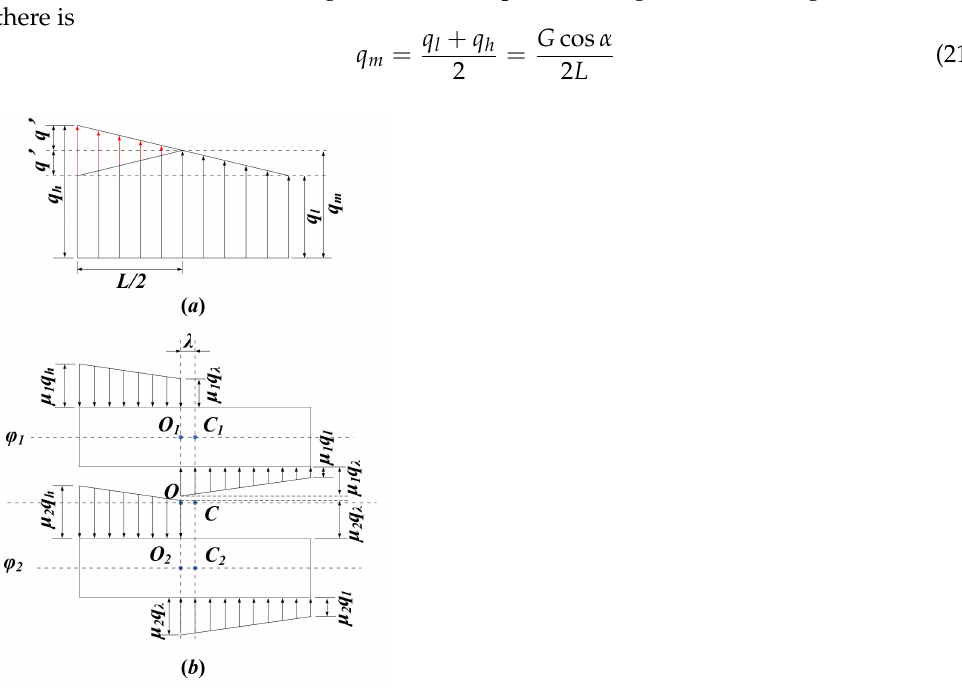
Figure 12. Load distribution diagram of the longitudinal slope track: ( a ) normal direction; ( b ) lateral